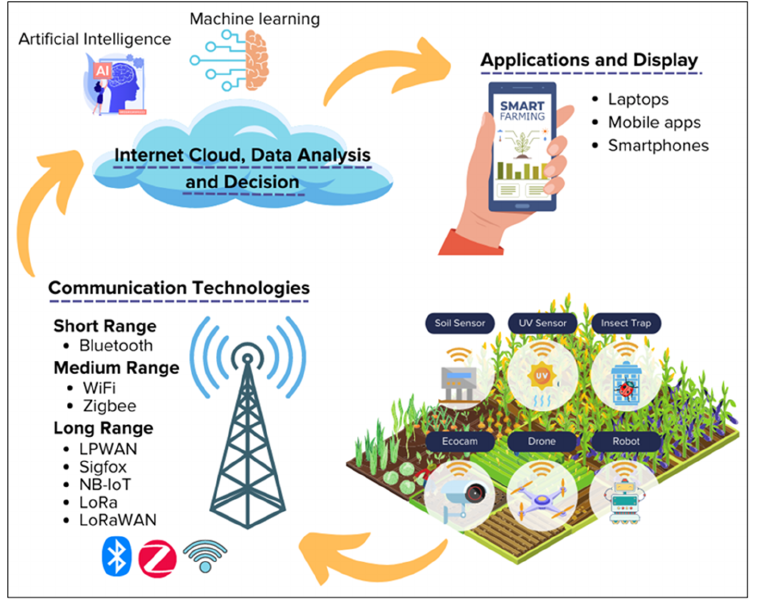
Figure 1. An architecture of smart farming components: Monitoring to end use applications.